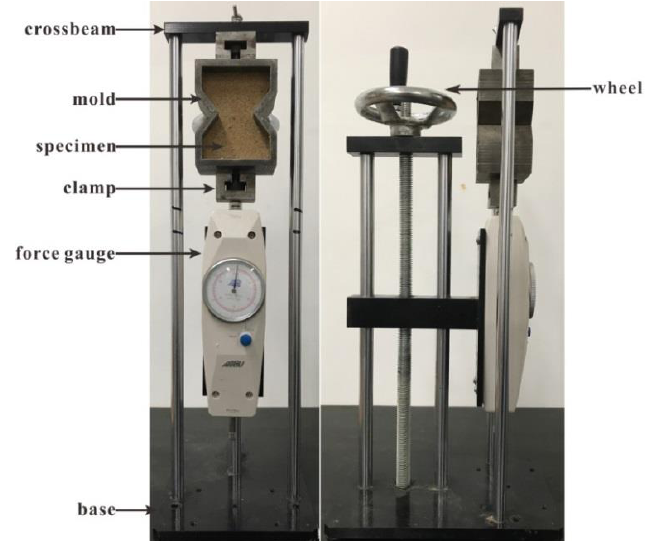
Figure 5. Photograph of the tensile test apparatus.